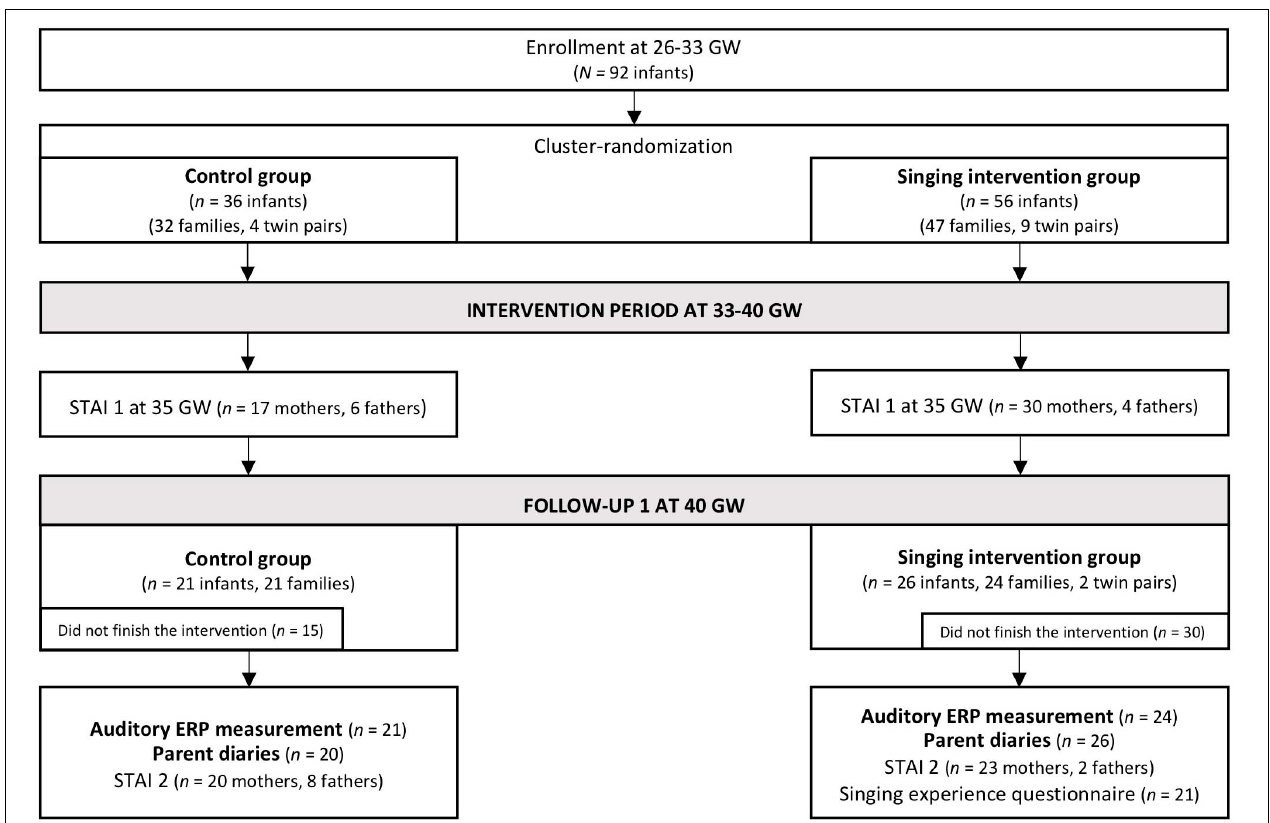
FIGURE 1 | Flowchart of the Finnish cohort of the Singing Kangaroo study (adapted from Kostilainen et al., 2021). The data used in the current study are highlighted in bold (the results of the STAI and questionnaire data are reported in Kostilainen et al., 2021).